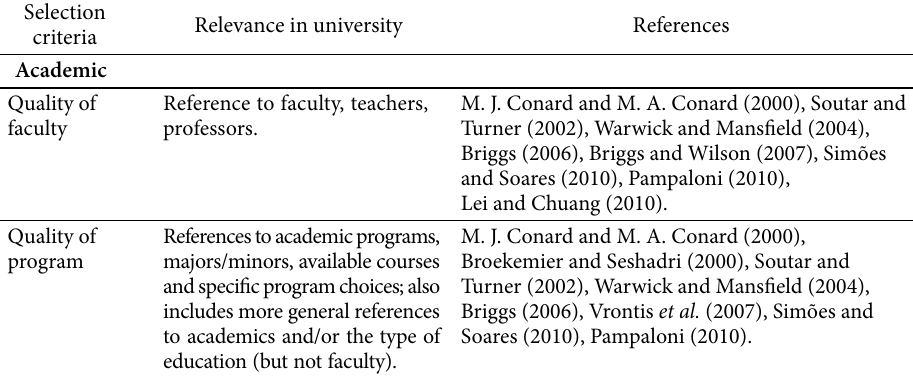
Table 1. Summary of literature on the criteria for the selection of a university Selection